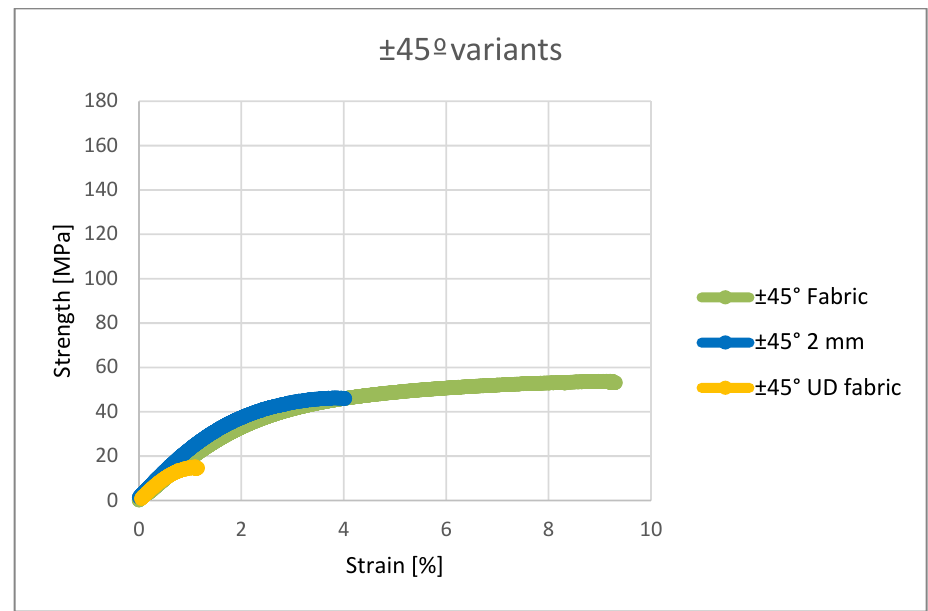
Figure 11. Strength and strain of the ±45° variants.